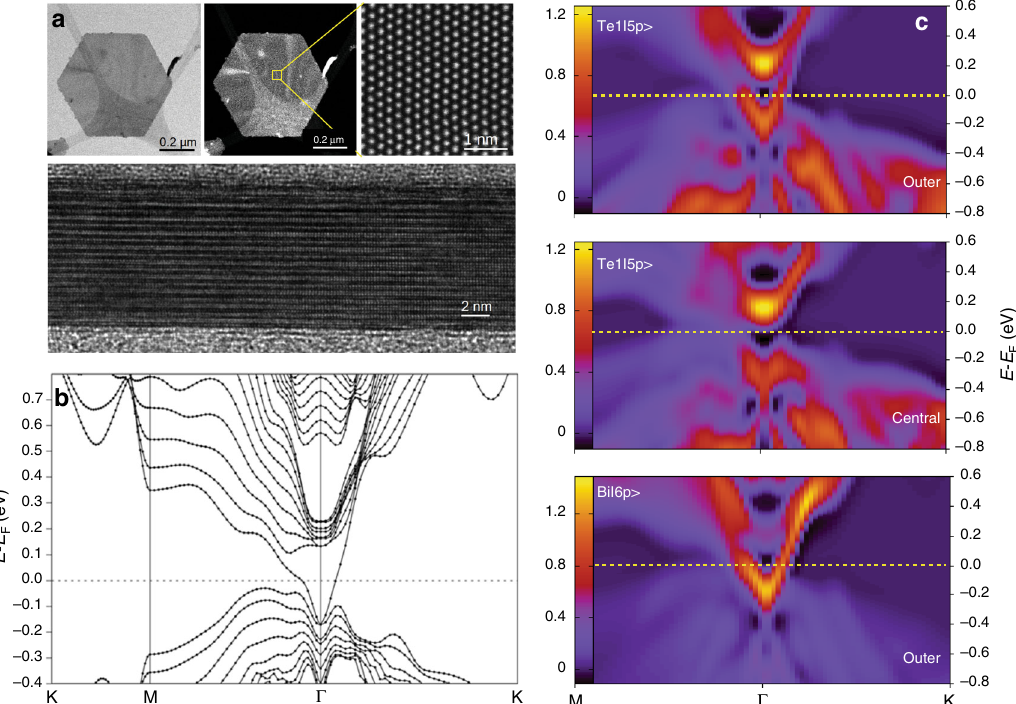
Fig. 1 Band structure analysis and Dirac states of stoichiometric Bi 2 Te 3 nanoplatelets. a High-resolution TEM and HAADF image of Bi 2 Te 3 nanoplatelets (top view and cross-section). b Band structure of a 9-quintuplets-thick ( ∼ 10 nm) Bi 2 Te 3 slab. c The projected k -resolved DOS of the Te(1) |5 p 〉 and Bi |6 p 〉 orbital states at the outer (edge) quintuplets, and the Te(1) |5 p 〉 orbital states at the central quintuplet. Dirac states are observed only at the edge quintuplets (more details in Supplementary Fig.